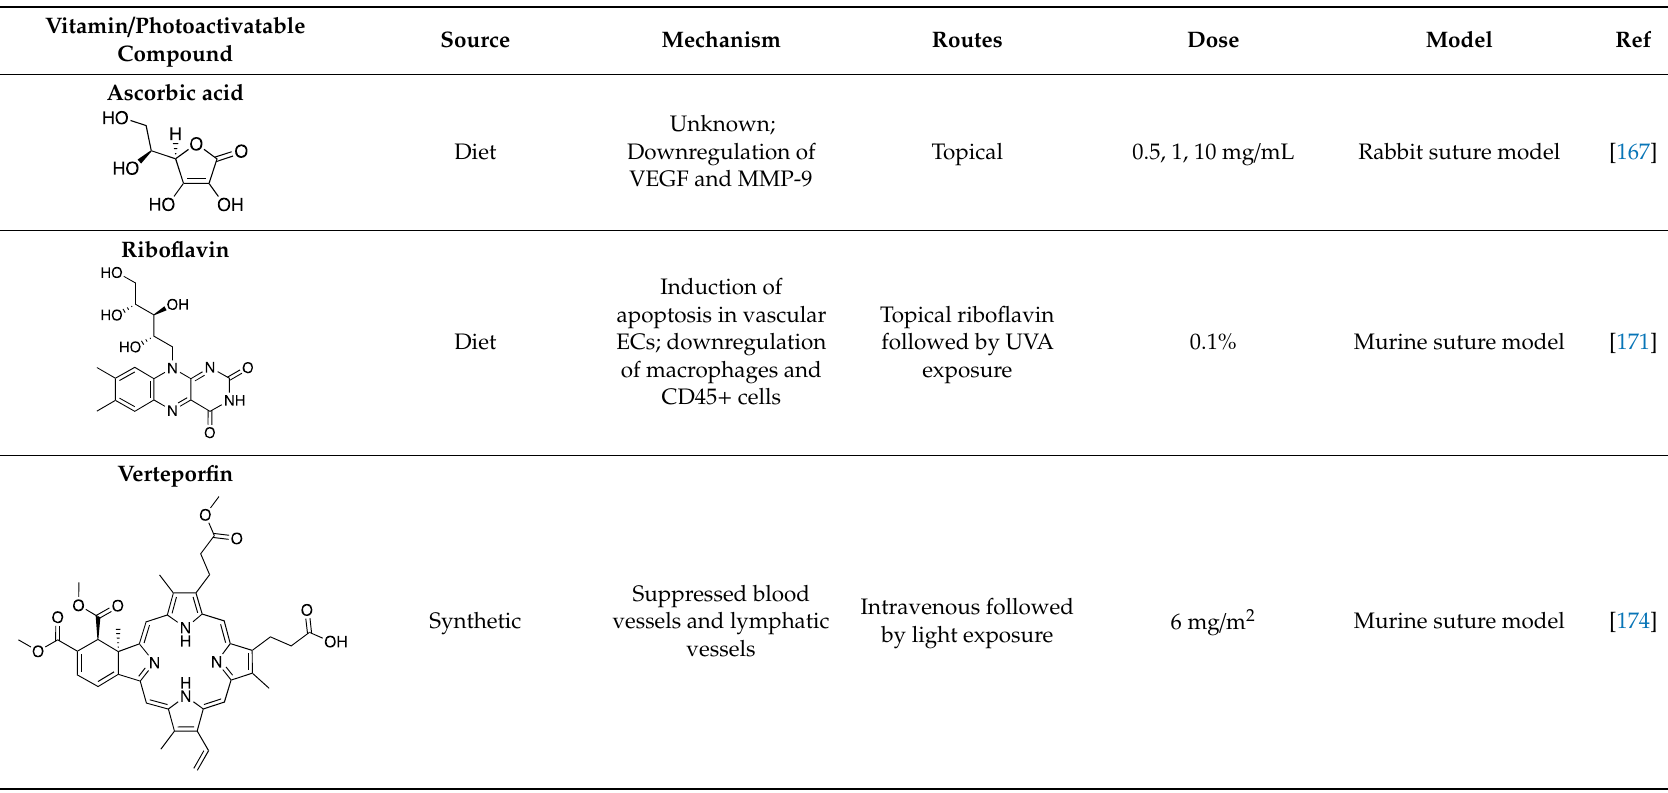
Table 7. Vitamins and photoactivatable small molecules tested in CoNV models.